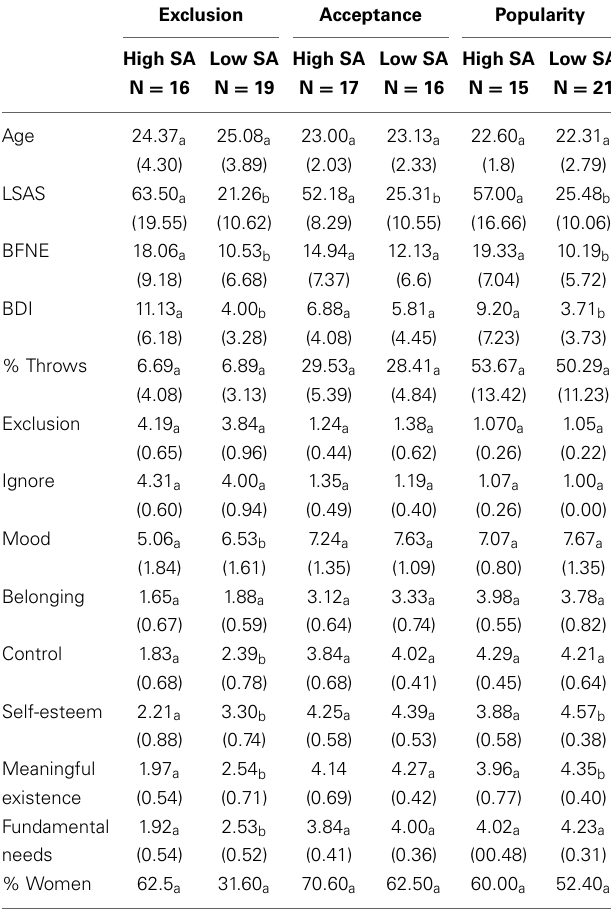
Table 1 | Means and standard deviation (in parentheses) of participants’ characteristics in the exclusion, acceptance, and popularity conditions according to social anxiety (SA)